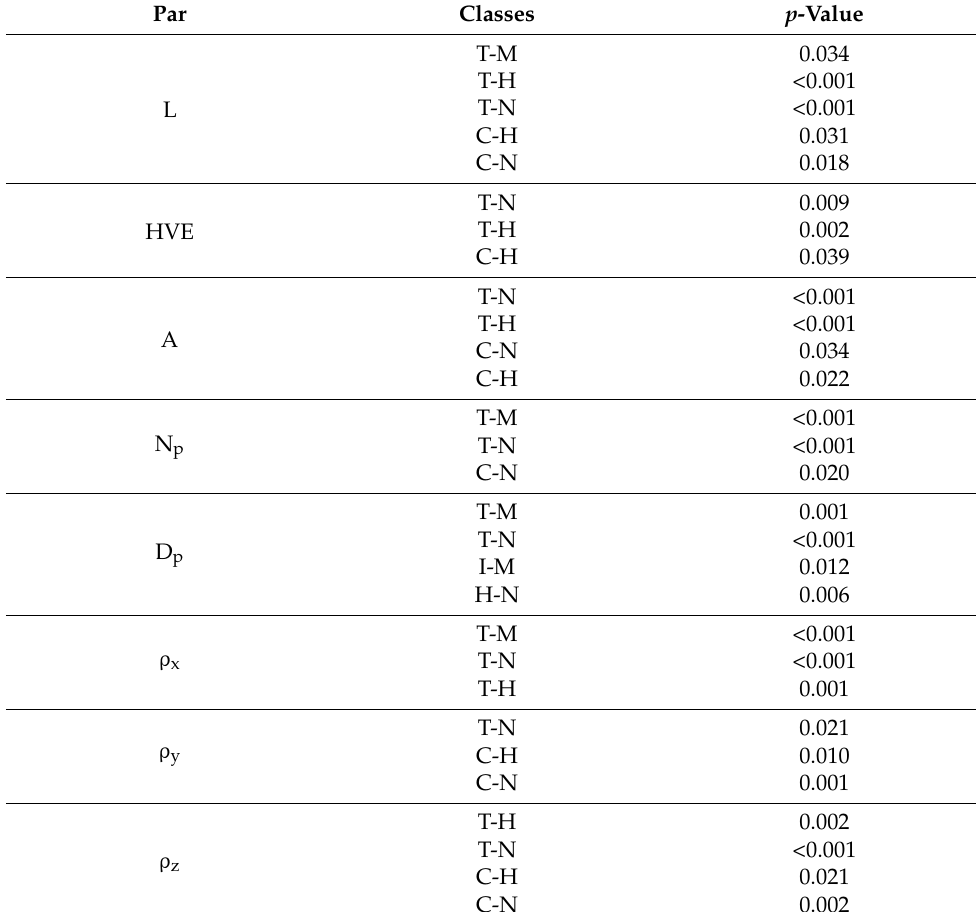
Table 2. Post-hoc for all the significant variables resulting from the Kruskal Wallis test.